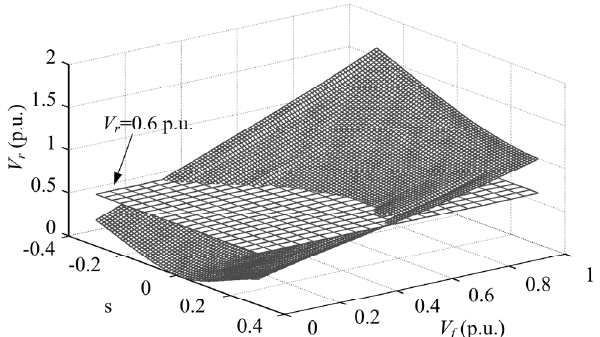
Figure 14. Feasible regions depending on the maximum output voltage of the RSC.